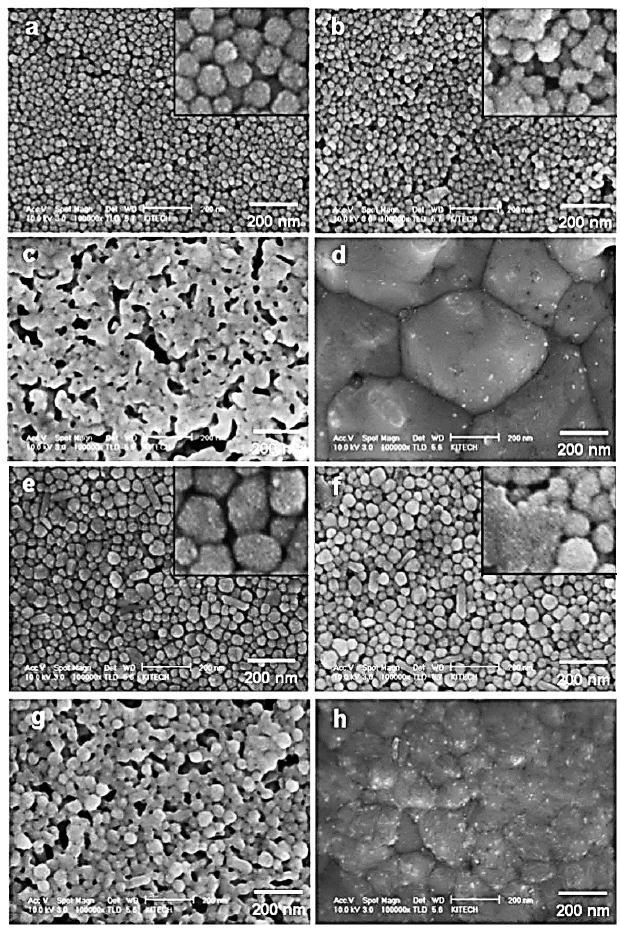
Figure 3. Increasing the Ag NPs size by increasing the sintering temperature: heat treatment of the thin film composed of 21 nm size NPs at ( a ) 100, ( b ) 140, ( c ) 200, and ( d ) 300 °C; heat treatment of the thin film composed of 47 nm size NPs at ( e ) 100, ( f ) 160, ( g ) 200, and ( h ) 300 °C. Reproduced with permission from [13]. Copyright 2005 ECS Publishing.